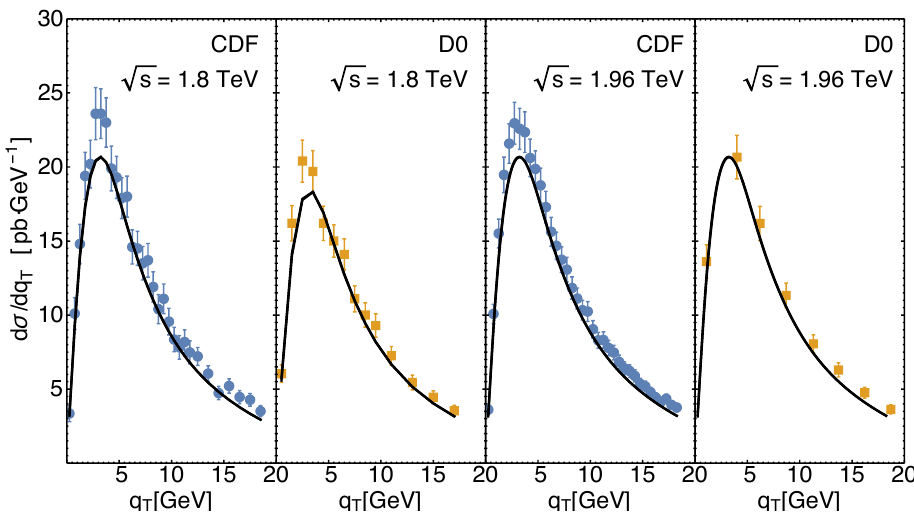
Figure 8 . Cross section differential with respect to the transverse momentum q T of a Z boson produced from p (cid:22) p collisions at Tevatron. The four panels refer to different experiments (CDF and D 0 ) with two different values for the center-of-mass energy ( p s = 1 : 8 TeV and p s = 1 : 96 TeV). In this case the band is narrow due to the narrow range for the best-fit values of g 2 .